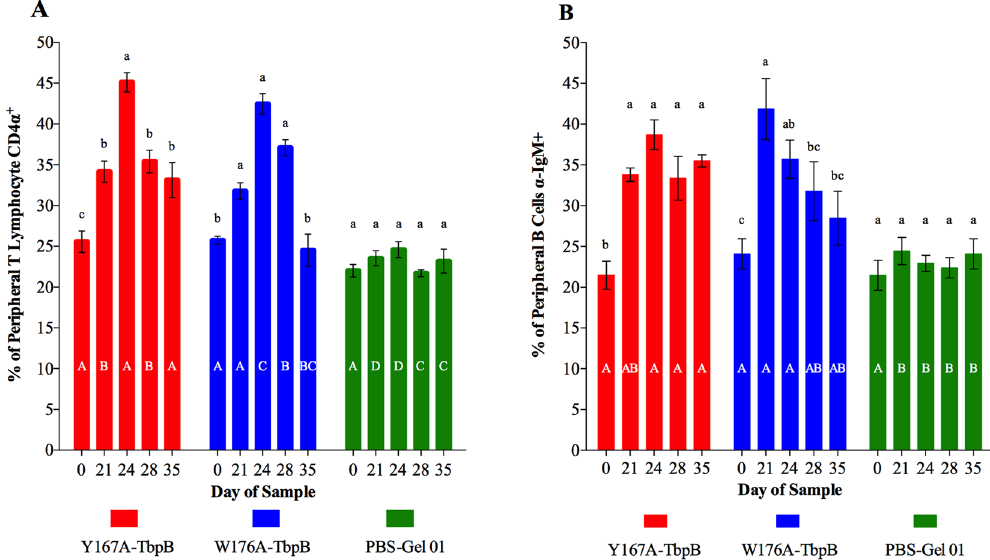
Figure 5. Cellular immune response during the vaccination protocol. Peripheral T lymphocytes CD4 α+ ( A ) and B cells α -IgM + ( B ) were analysed by flow cytometry before and after each immunization. Results are expressed as cell percentage relative to the total cells gated into the lymphocytes region (FSC vs SSC). Lower case letters indicate significant differences (p < 0.05) between the different days within the group. Capital letters indicate differences between the same days for different groups.